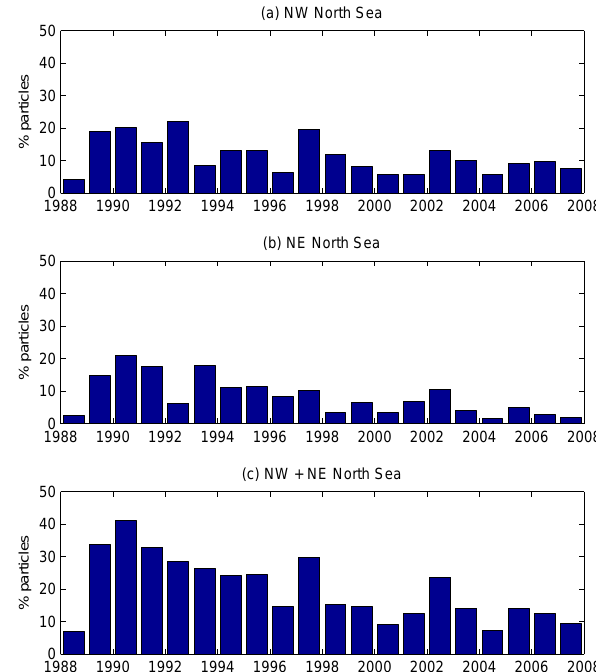
Figure 11. Histograms (per year) of mean fraction of (combined) January and July released particles residing: (a) in the northwest North Sea (4.5 ◦ W to 1.5 ◦ E, south of 59 ◦ N); (b) in the northeast North Sea (east of 1.5 ◦ E, south of 62 ◦ N); (c) the combined